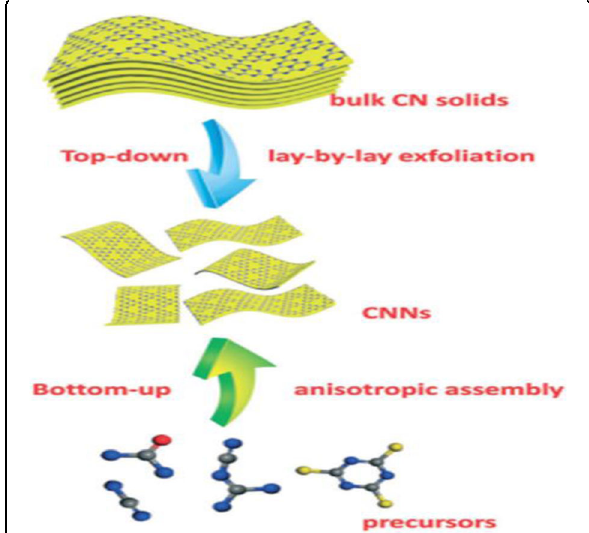
Fig. 5 Schematic illustration of synthesizing CNNs by using the top – down and bottom – up strategies (reproduced from ref. [121] with permission from The Royal Society of